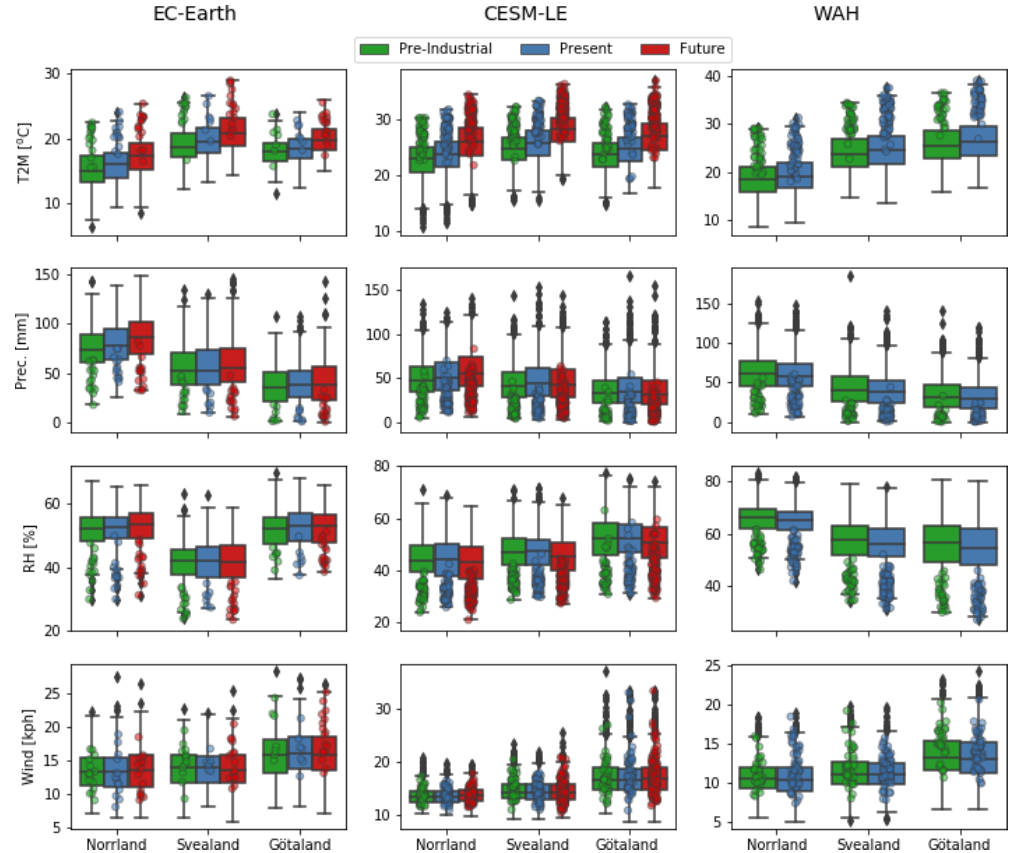
Figure 8. Meteorological values associated with the yearly maximum FWI in July and August, with a 7d rolling average applied, for all three climate states in all three regions. Precipitation is calculated as 30d cumulative value prior to the yearly maximum FWI. The box plot shows the quartiles of the distribution, the whiskers the rest of the distribution and the dots are outliers. The circles indicate all values in the distribution associated with FWI higher than the observed 2018